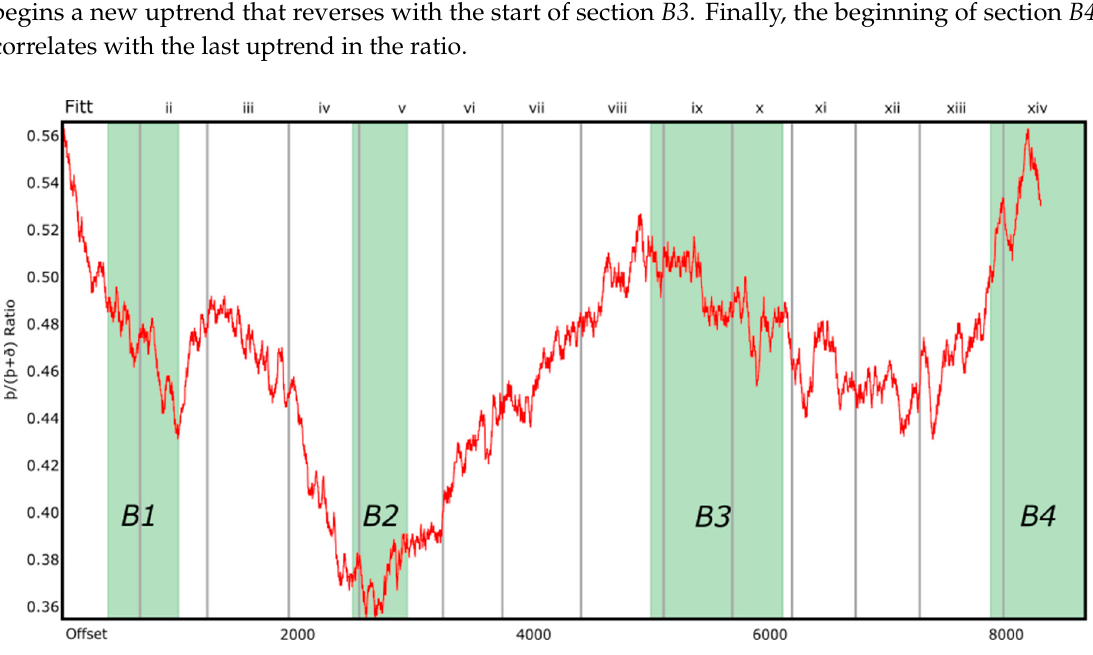
Figure 9. The moving ratio of þ to ð in Andreas , 1000-word window.